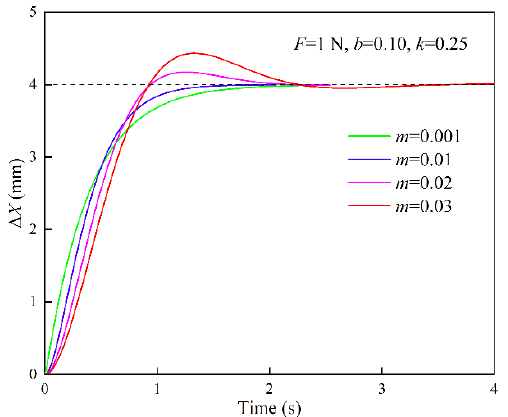
Figure 4. Response curves of position correction amount under different inertia parameters ( m : N·s 2 /mm; b : N·s/mm; k : N/mm).